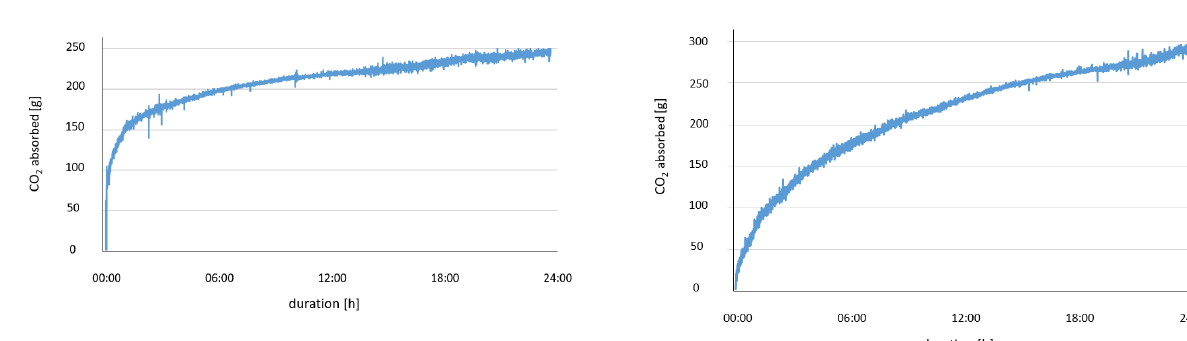
Figure 3. Carbonation results for C25/30, CEM II- B, grain size 0 8mm. −